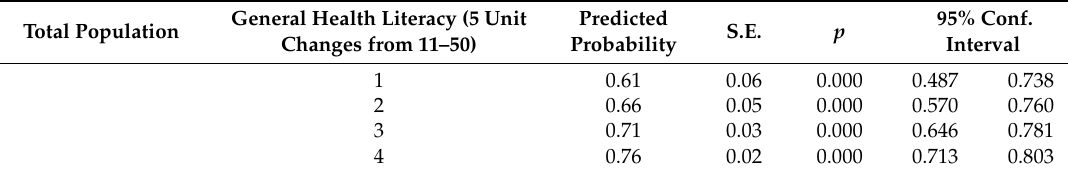
Table A1. Self-rated health